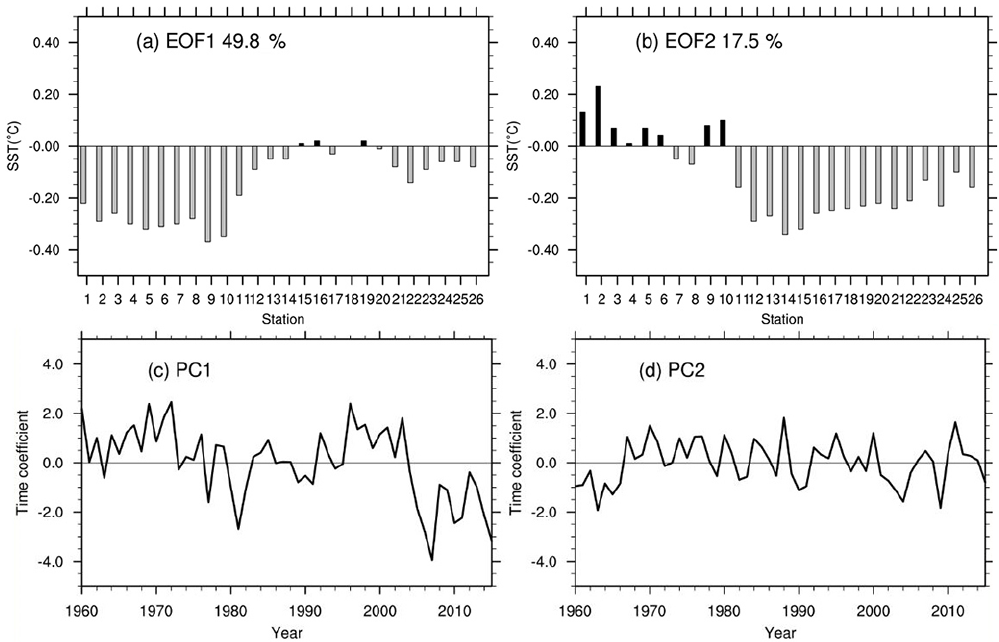
Figure 5. EOF analysis of the differences for LH–LA-COBE: (a, b) EOF spatial patterns (EOFs), (c, d) principal components (time coeffi- cients).